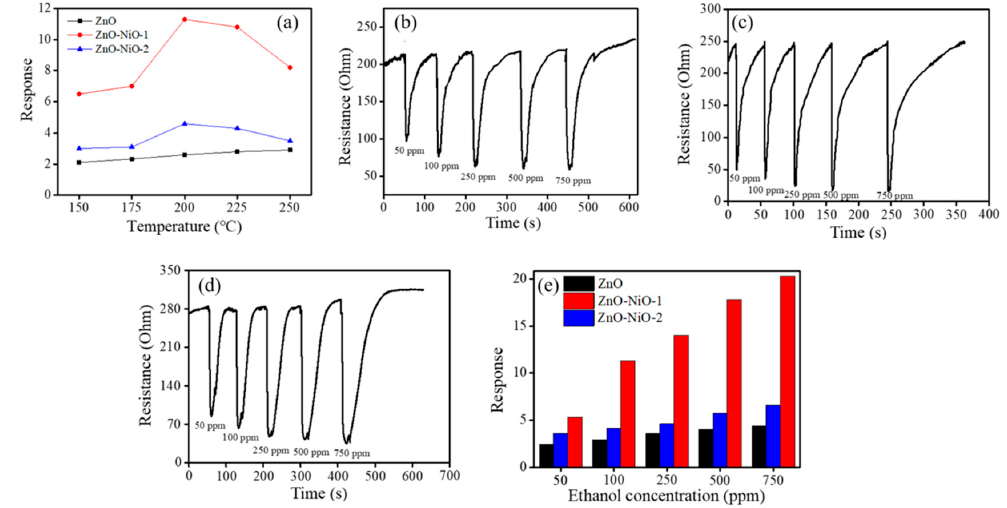
nanosheets: ( b ) ZnO, ( c ) ZnO-NiO-1, and ( d ) ZnO-NiO-2. ( e ) Gas-sensing response values vs. ethanol vapor concentrations for the sensors made of various porous